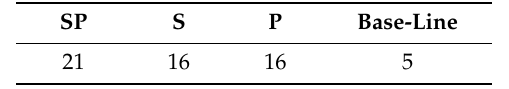
Table 4. Number of good participants for each